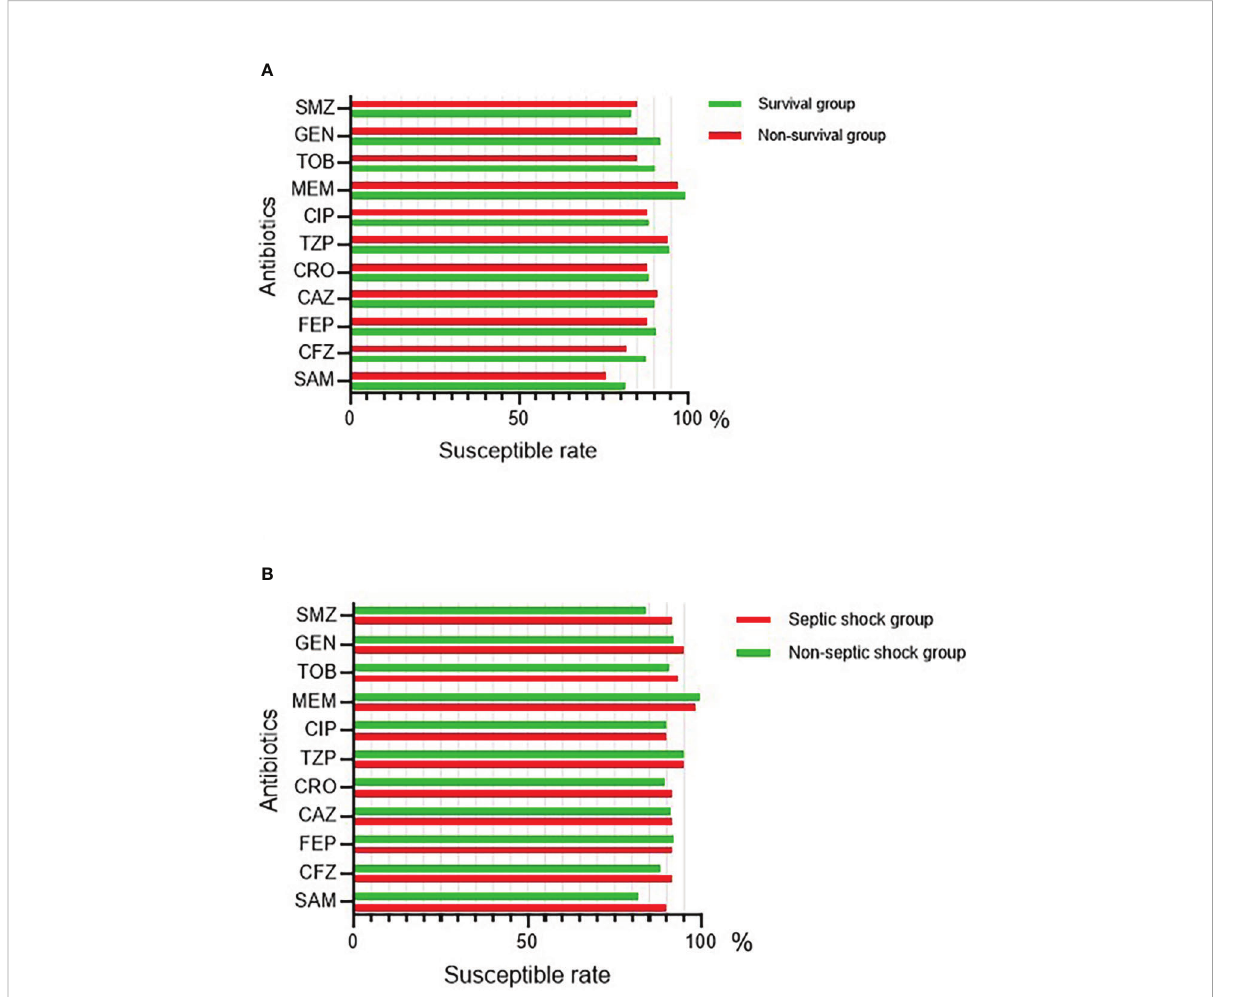
FIGURE 2 The antimicrobial susceptibility of BSI-KP in 279 patients. (A) The antimicrobial susceptibility of BSI-KP in survival and non-survival group. (B) The antimicrobial susceptibility of BSI-KP in septic shock and non-septic shock group. SAM, ampicillin/sulbactam; CFZ, cefazolin; FEP, cefepime; CAZ, ceftazidime; CRO, ceftriaxone; TZP, piperacillin/tazobactam; CIP, cipro fl oxacin; MEM, meropenem; TOB, tobramycin; GEN, gentamicin; SMZ,